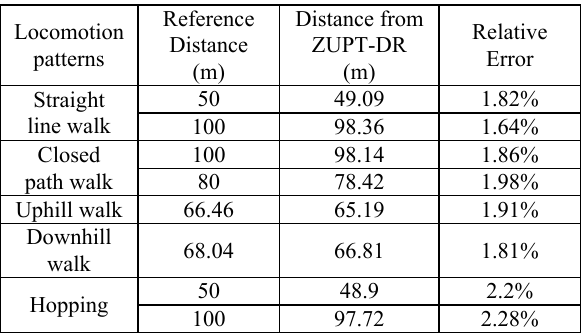
Table 2. The positioning accuracies in the